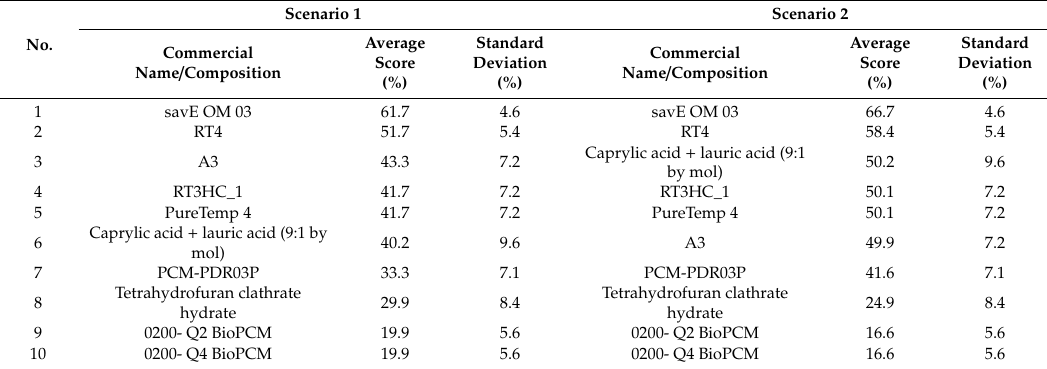
Table 5. Average score obtained by the PCM candidates for the MED system.